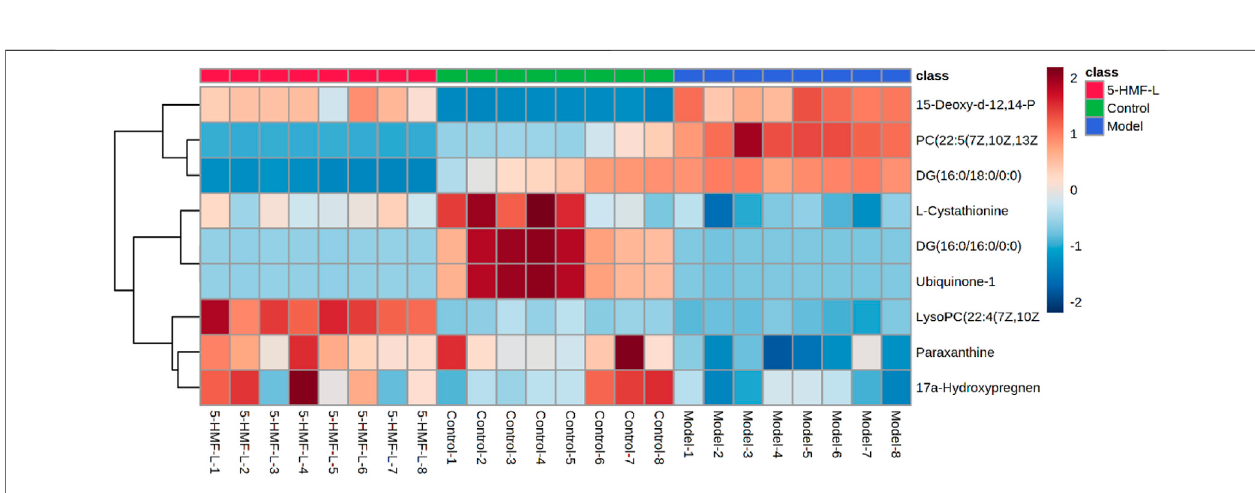
Frontiers in Pharmacology |